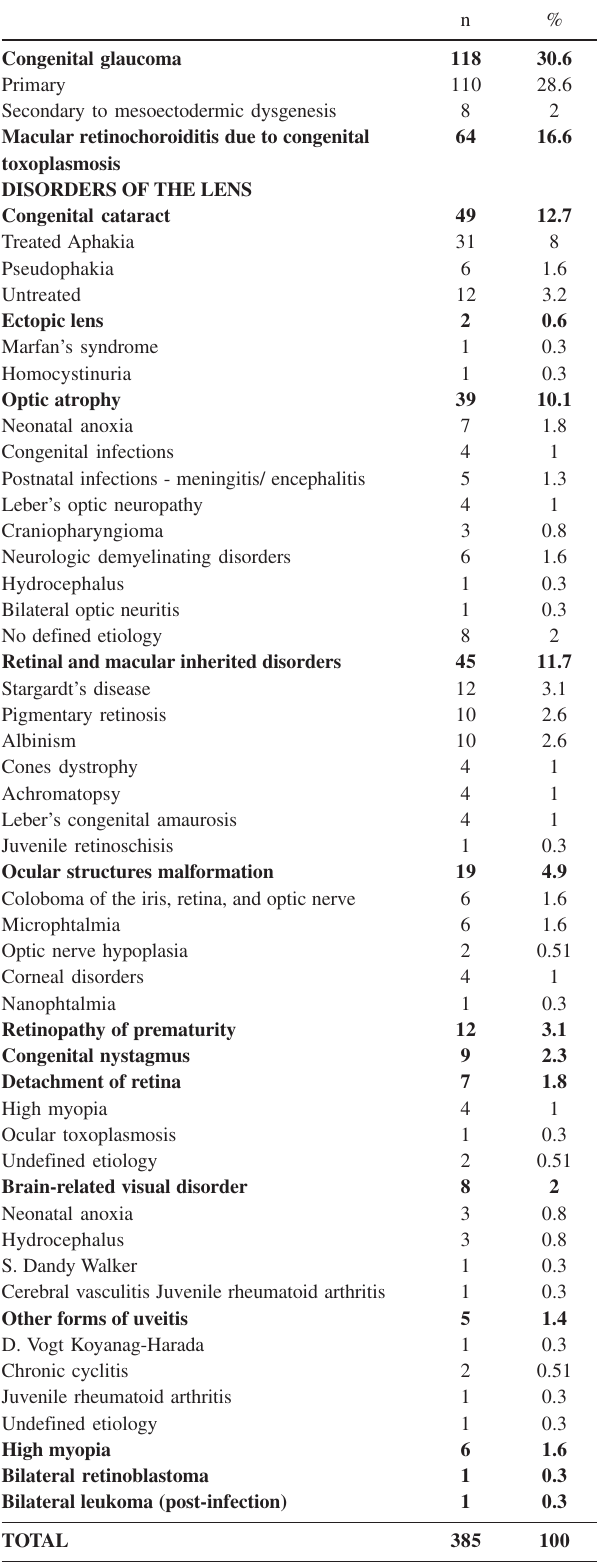
Table 3 - Distribution of the pediatric population by site of